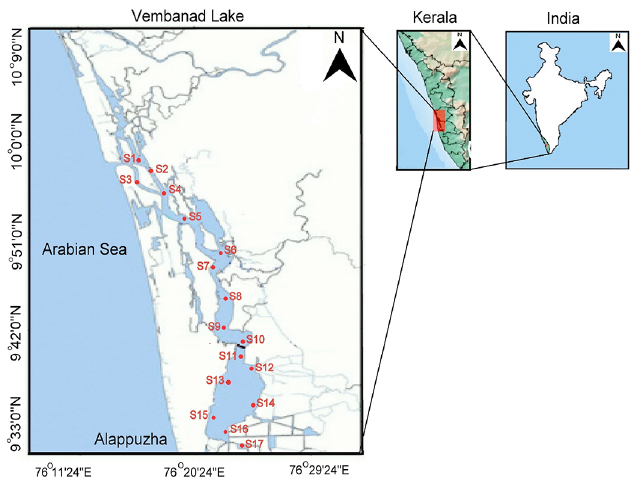
Fig. 1. Map of Vembanad lake (S. India) showing sampling